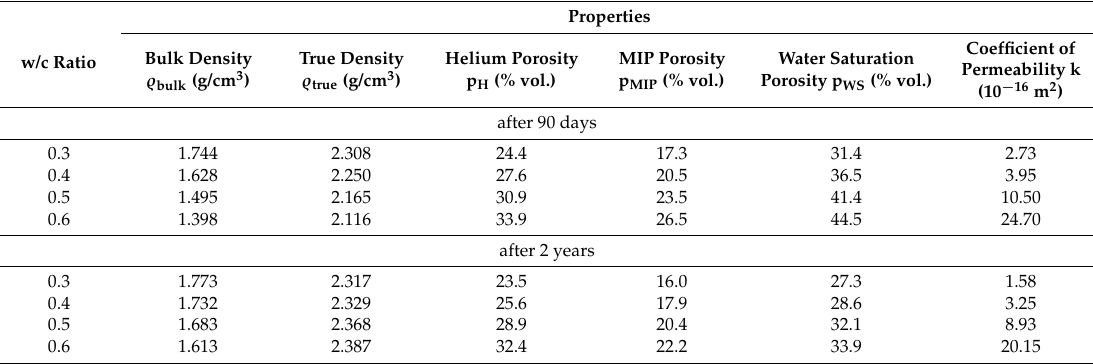
Table 2. Results of density, porosity and permeability tests for the cement pastes tested.